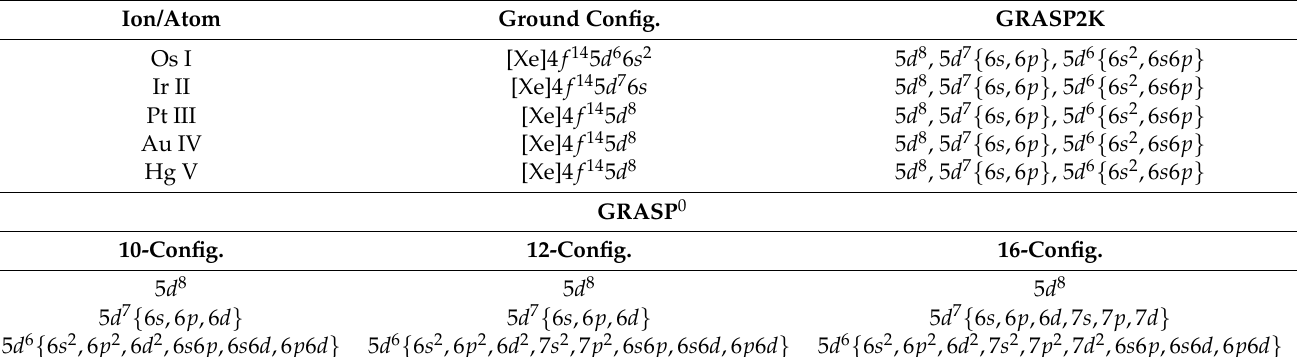
Figure 1. Energy level diagrams for ( a ) Os I, ( b ) Ir II, ( c ) Pt III, ( d ) Au IV, and ( e ) Hg V, comparing our results to available NIST data [20] and HULLAC calculations [8,25]. Each stack of levels refers to excited states from the indicated configuration. Table 1. GRASP2K and GRASP 0 target models adopted in the current work. Ion/Atom Ground